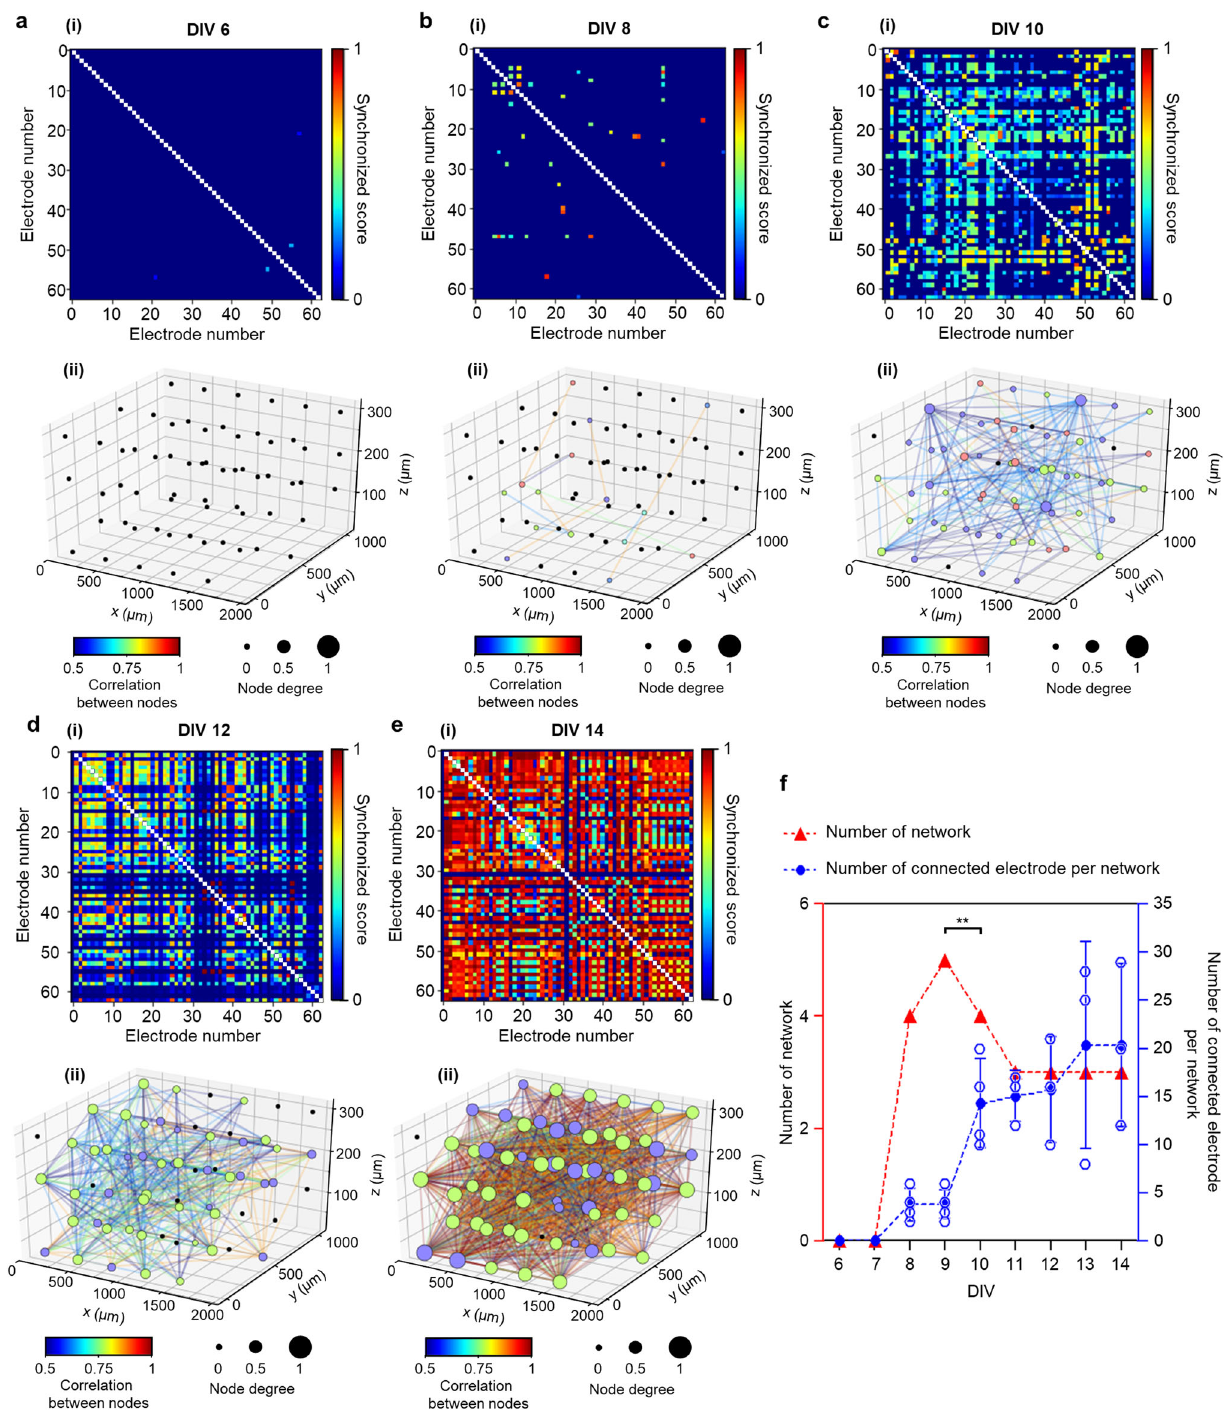
Fig. 3 Analysis of neural network dynamics based on spontaneous activities in the single-group 3D neural network model. a – e Color-mapped cross- correlation matrices displaying synchronized scores between electrodes ( i ) and 3D network maps showing connectivities with node degrees, as well as correlations between nodes ( ii ), based on spontaneous activities at days in vitro (DIV) 6 ( a ), 8 ( b ), 10 ( c ), 12 ( d ), and 14 ( e ). The color of the node indicates the network index connected among electrodes; for example, the purple nodes at DIV 14 indicate that the nodes are in the same network. Node degree indicates the number of connected electrodes from each electrode; for example, the greatest value of 1 represents that the electrode is connected with all electrodes. The colors of the lines indicate the correlation between electrodes. f Plots showing the number of networks (red triangle and dotted line; ** P = 0.002 between DIV 9 and 10) and the number of connected electrodes per network (blue circle and dotted line) from DIV 6 to 14. Data are presented as mean values + / − s.d. with individual data points (blue outlined circle; n = 3 networks for DIV 11, 12, and 14; n = 4 networks for DIV 8, 9, 10, and 13). Statistical signi fi cance was tested with a two-tailed unpaired t -test. Source Data is available as a Source Data fi le for Fig. 3a –